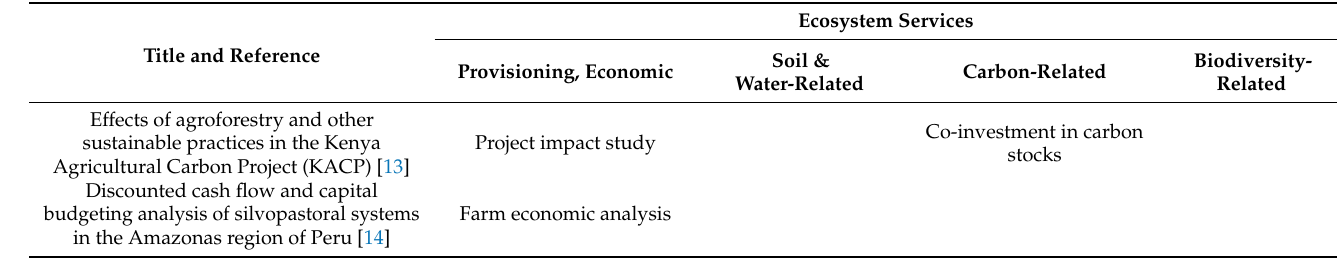
Table 2. Papers addressing efforts to increase the feedback from external stakeholders to land use decisions (including ‘agroforestry’) within